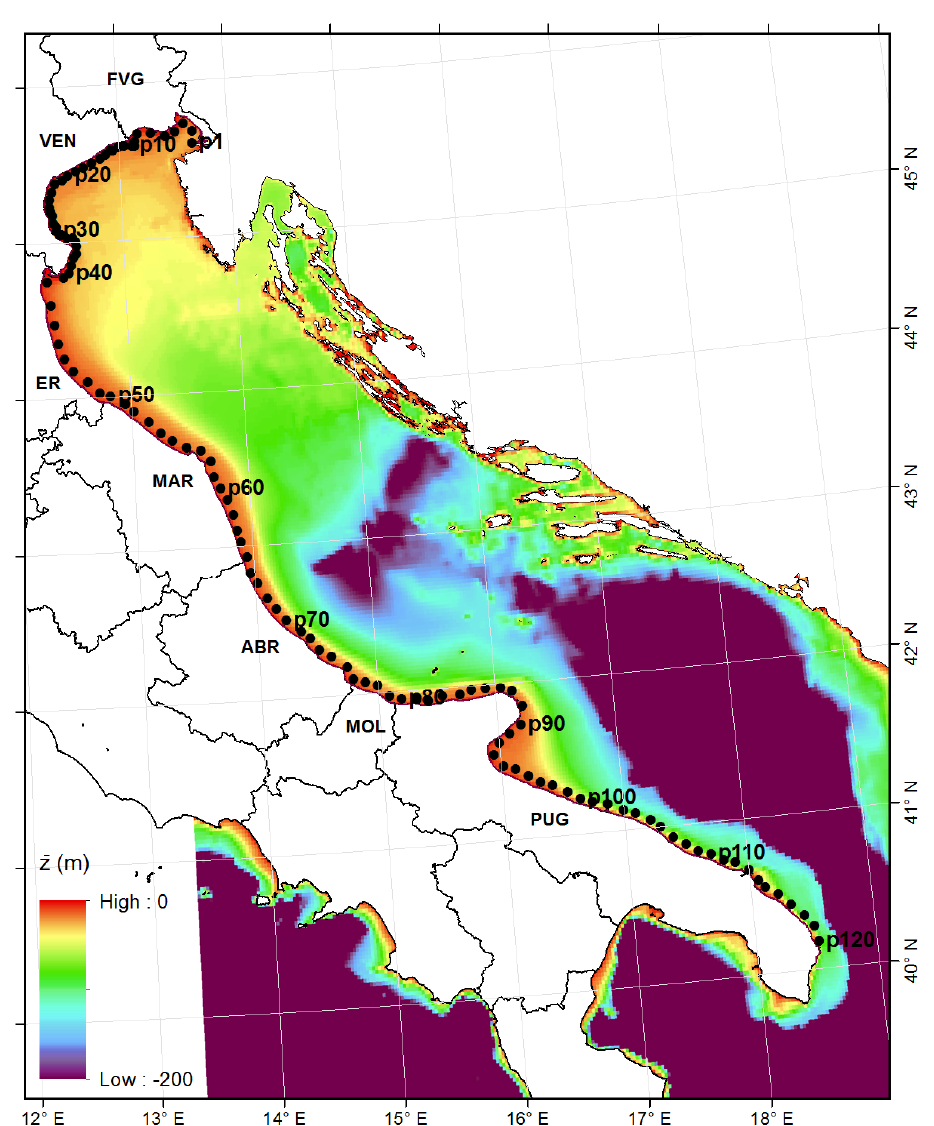
Figure 1. Wave model bathymetry in the Adriatic Sea and locations of the 120 points along the Italian Adriatic coast where the wave characteristics are extracted. The boundaries of the Italian administrative regions are highlighted with the abbreviations of the 7 that face the Adriatic Sea.